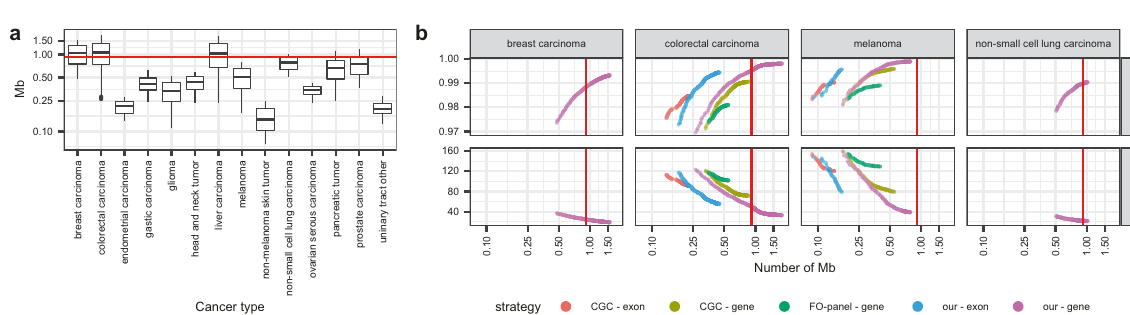
Bold values indicate the number of genes and size of the only panel for TMB estimation we suggest for each malignancy.